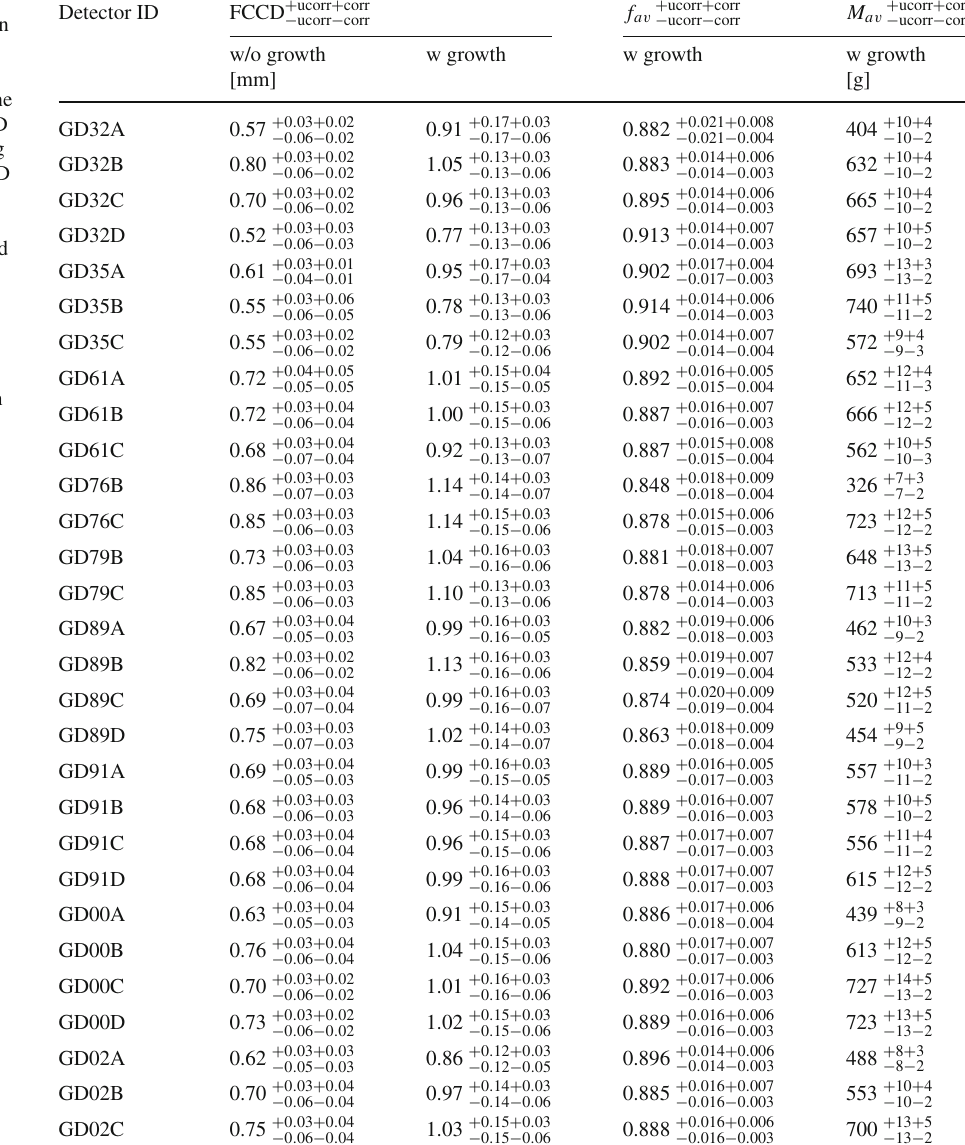
Table 9 Official dataset of FCCD and AV fractions used in Gerda Phase II physics analyses: The FCCD values were obtained by combining the 241 Am FCCD and 133 Ba FCCD values (1st column) and adding an offset that considers a FCCD growth at room temperature (2nd column). The offsets are individual for each detector and consider different storage periods. The AV fractions (3rd column) were deduced via subtraction of the FCCD volumes from the crystal masses. The active masses (4th column) were quoted by multiplying the crystal masses with the AV